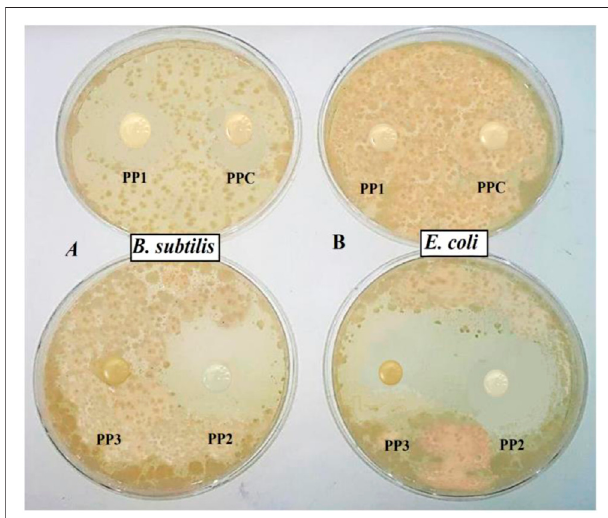
FIGURE 5 | Antimicrobial activity of fabricated hydrogels after 24 h against (A) Bacillus subtilis MH-4 (G+) (B) Escherichia coli BL-21 (G-).